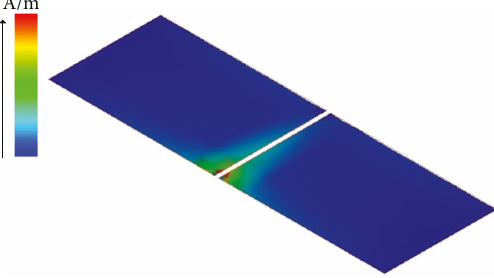
Figure 4: Simulated S -parameters: S di ff erent lengths.